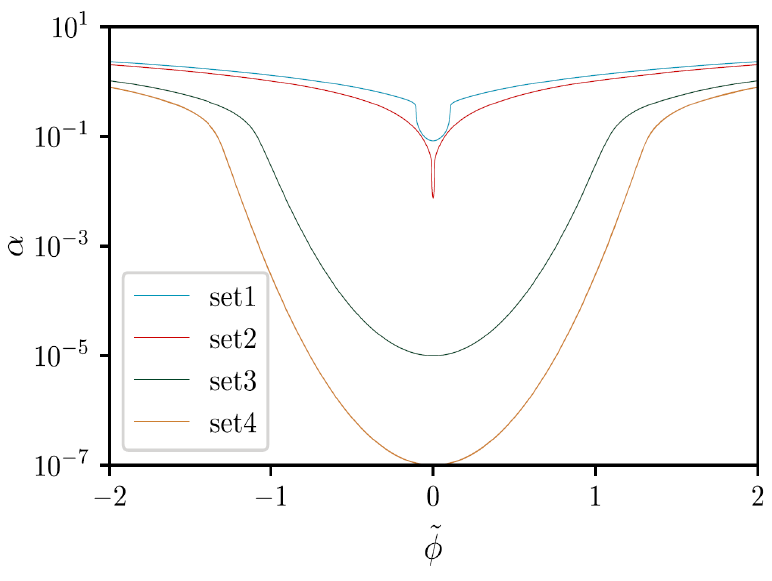
Figure 8. Possible Bohmian trajectories associated with the canonical scalar field with exponential potential. The trajectories yielding relevant amplification of scalar perturbations are set 1 and set 2. The bounces are not deep, but they are steep, with very small x